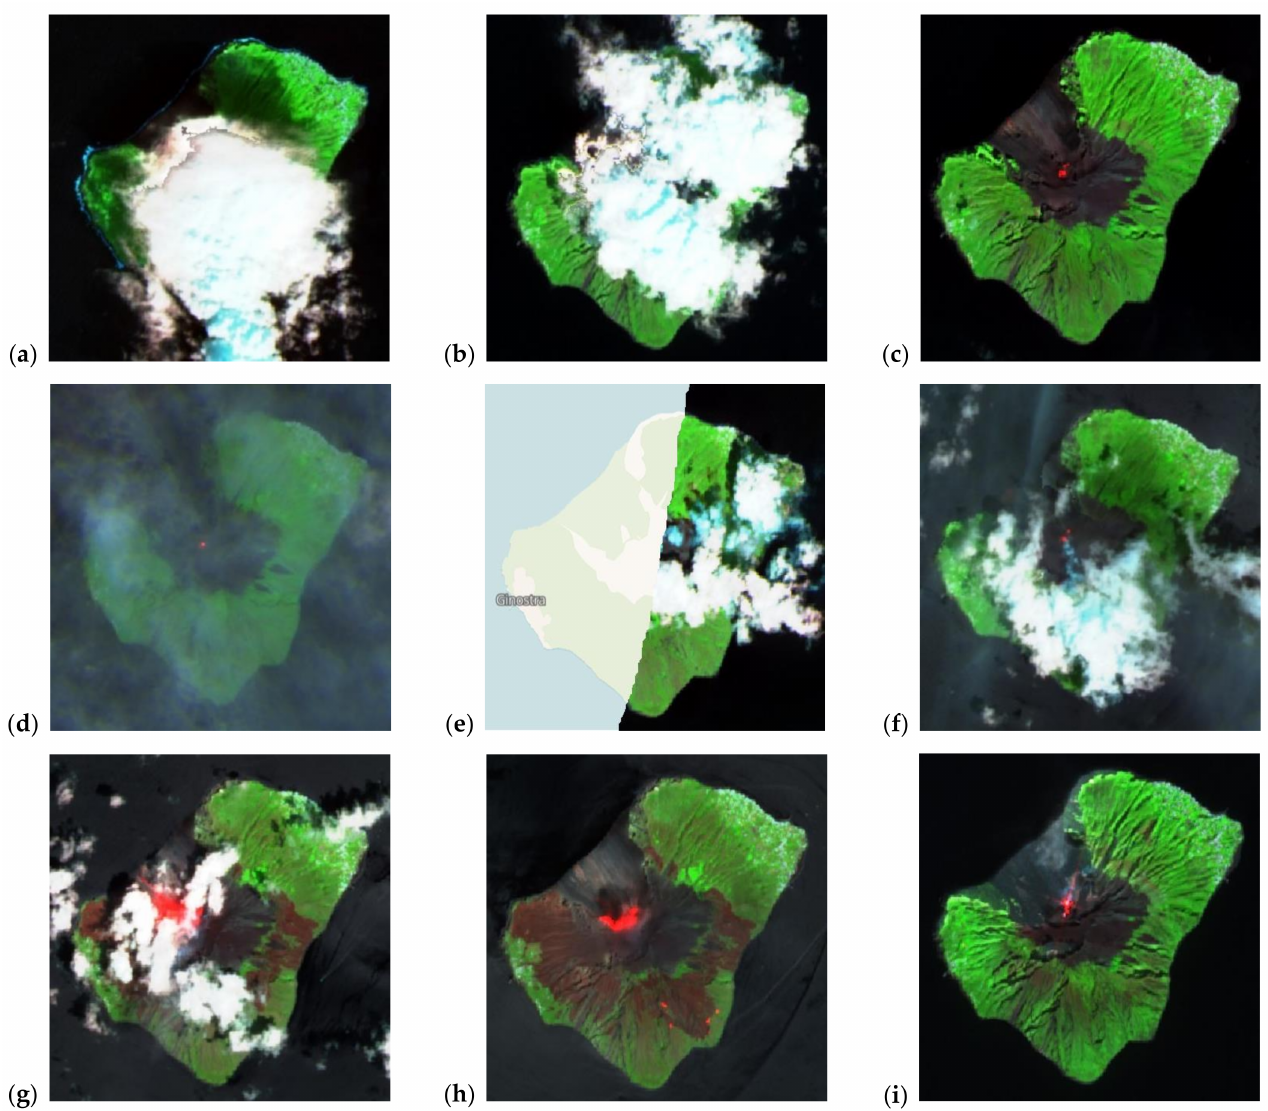
Figure 4. Sentinel-2 false color composites (R: band 12—short-wave infrared; G: band 8A—red edge; B: band 4—red) for: ( a ) 14 March 2019, ( b ) 19 March 2019, ( c ) 24 March 2019, ( d ) 18 May 2019, ( e ) 20 May 2019, ( f ) 23 May 2019, ( g ) 22 July 2019, ( h ) 27 July 2019 and ( i ) 6 February 2021. Contains Copernicus Sentinel-2 data 2019, processed in Sentinel Hub